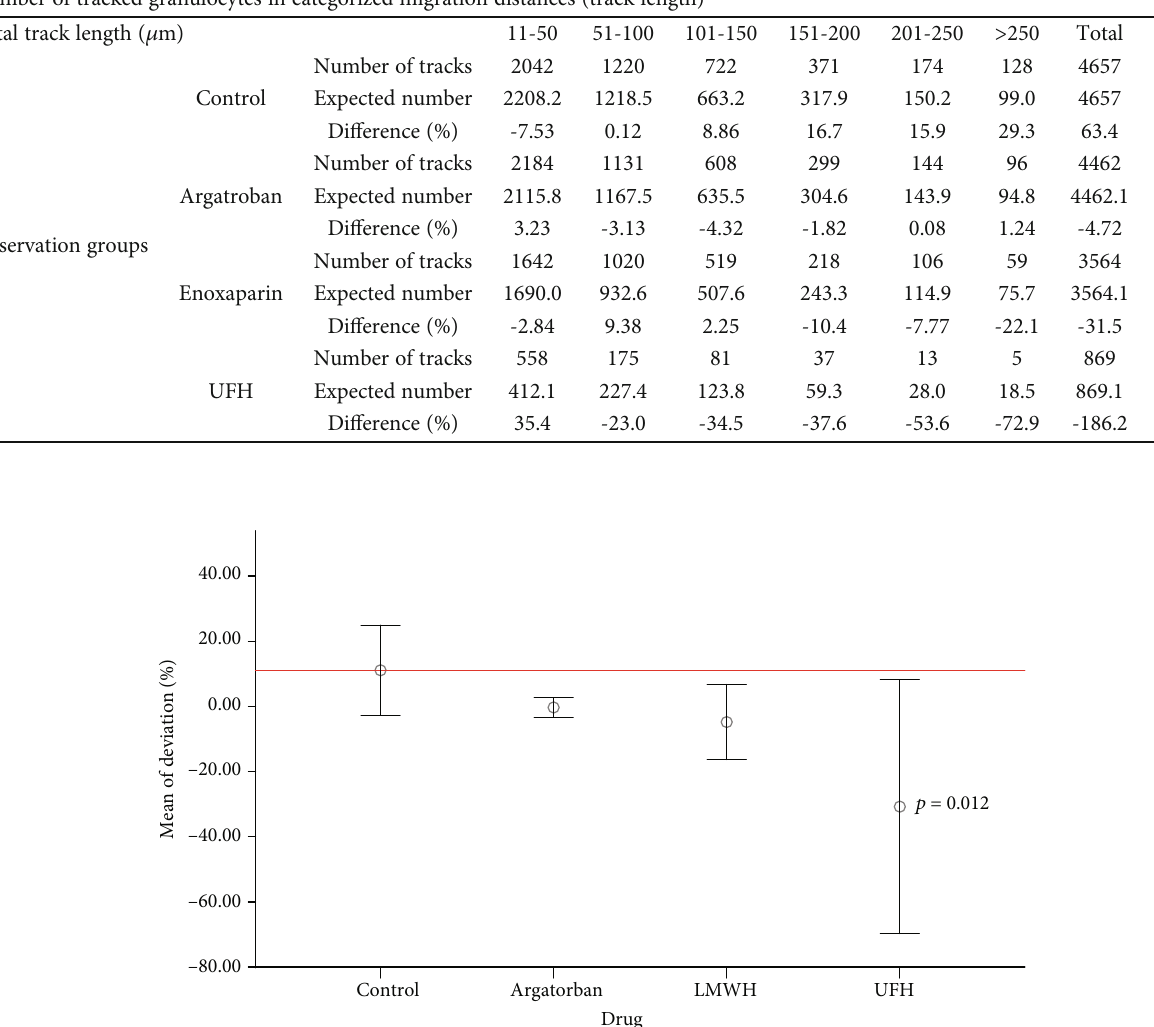
Figure 2: Number of tracked granulocytes: there were no signi fi cant di ff erences in the relative deviations between the argatroban, LMWH, and control groups. Only the UFH group di ff ered signi fi cantly from the control ( p = 0 : 012 ). LMWH: low-molecular-weight heparin; UFH: unfractionated